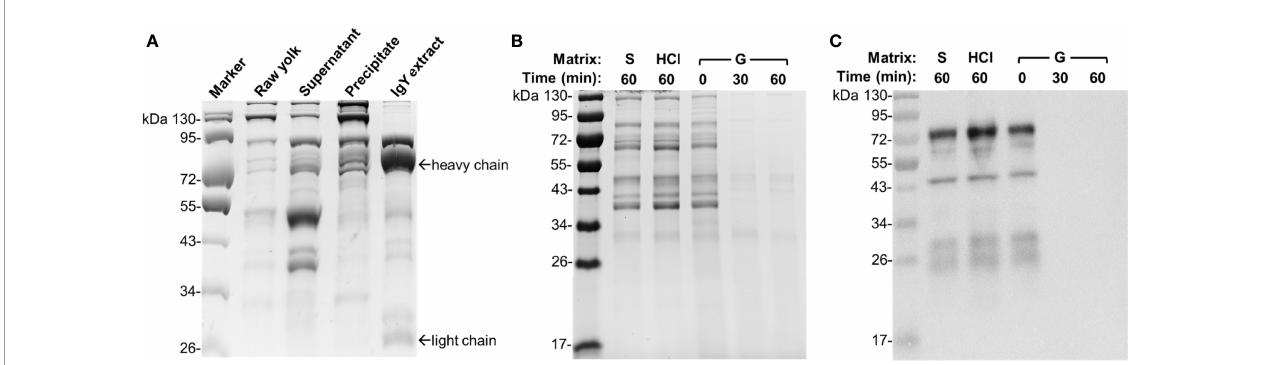
FIGURE 2 | Integrity of egg yolk IgY in response to the treatment with HCl or gizzard content. (A) SDS-PAGE analysis of stepwise puri fi cation of IgY from egg yolk. Raw yolk: the egg yolk prior to IgY puri fi cation; supernatant and precipitate: the fractions obtained following centrifugation of 12% PEG 6000-treated egg yolk mixture; IgY extract: the puri fi ed IgY after fi nal dialysis. (B) SDS-PAGE and (C) immunoblotting analyses of the integrity of egg yolk IgY in response to the treatment with HCl (1 mM, pH 3.0) or a representative gizzard content (pH 3.0) at 42°C for the indicated length of time. The reconstituted hyperimmune egg yolk powder was used as stock to spike different matrixes as described in the Materials and Methods . The far left lane is a protein marker. Abbreviation of the matrix system for treating egg yolk IgY: S, saline; G, gizzard